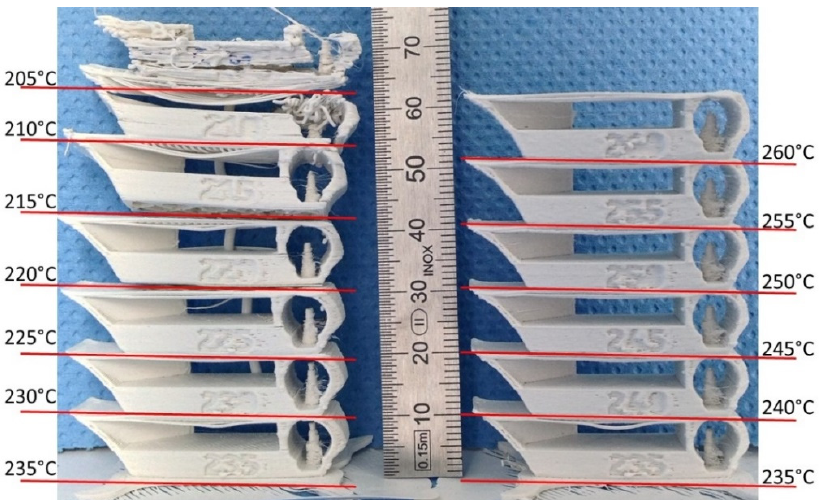
Figure 10. Parts printed at different temperatures showing the temperature range for the PA12-ZrO 2 Fused Filament Fabrication.